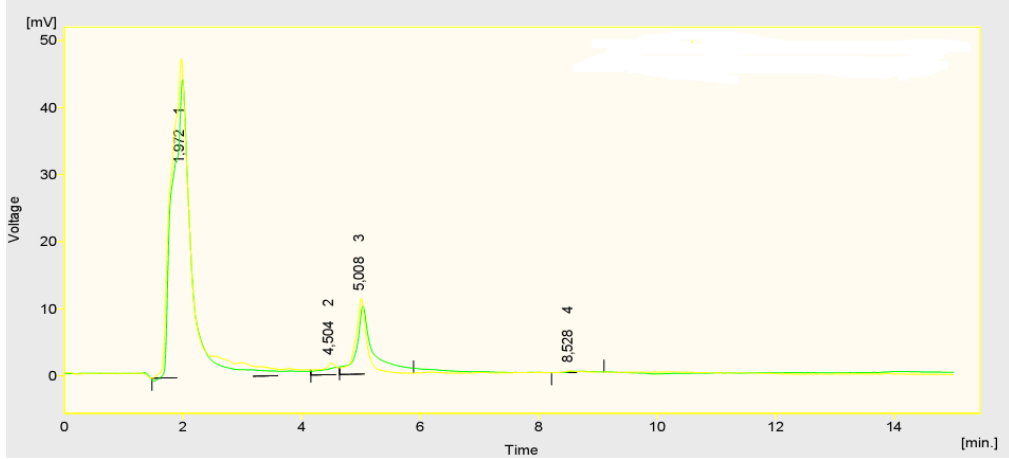
Table 1. Total flavonoid and ascorbic acid contents (g/kg FM) of fruits of